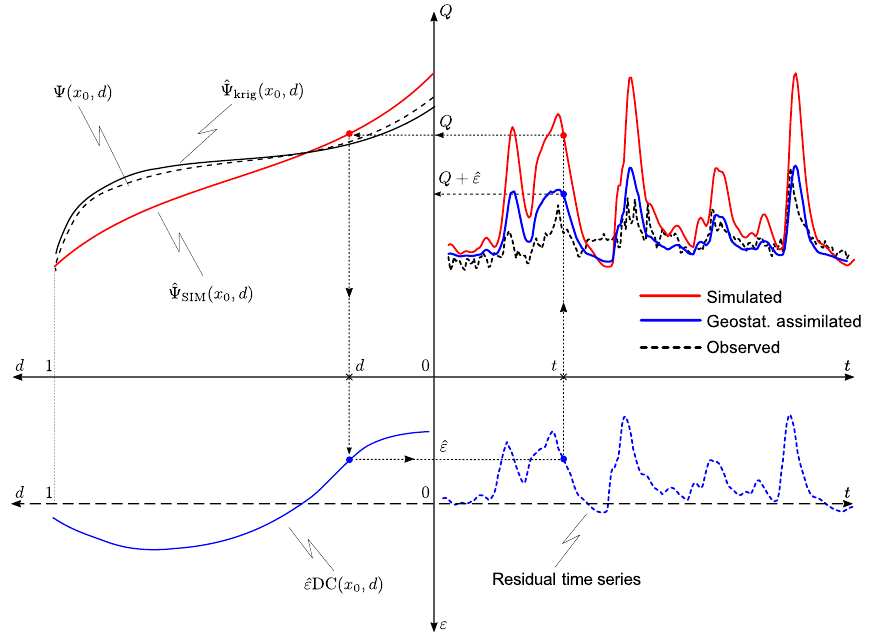
Figure 2. Illustration of the proposed data-assimilation procedure for a given simulated time series. Top-right panel: real streamflow series (unknown, since the basin is ungauged, black dashed line); macro-scale model simulation (red solid line); geostatistically enhanced stream- flow series (blue solid line). Top-left panel: FDC predictions obtained from simulated streamflows (red solid line) and via geostatistical interpolation (black solid line), with real (unknown) FDC (black dashed line). Bottom-left panel: estimated residual–duration curve (blue solid line) computed as the difference between the two predicted FDCs in the top-left panel. Bottom-right panel: time series of residuals (blue dashed